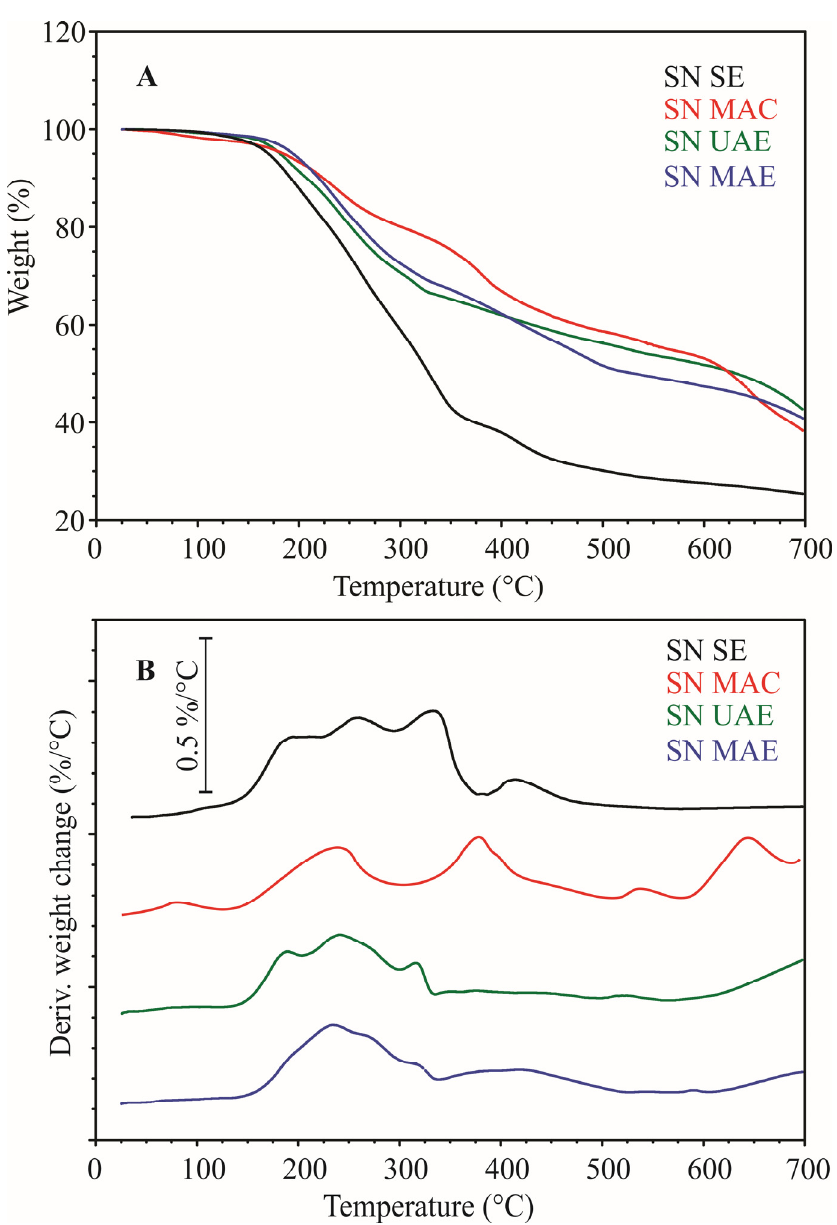
Figure 2. Thermogravimetric—TG ( A ) and differential TG—DTG ( B ) curves of dried nettle extracts. Heating rate 5 °C/min, nitrogen flow 60 mL/min.